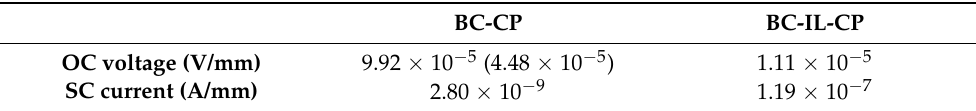
Table 2. Slopes of the linear regression for data reported in Figures 12 and